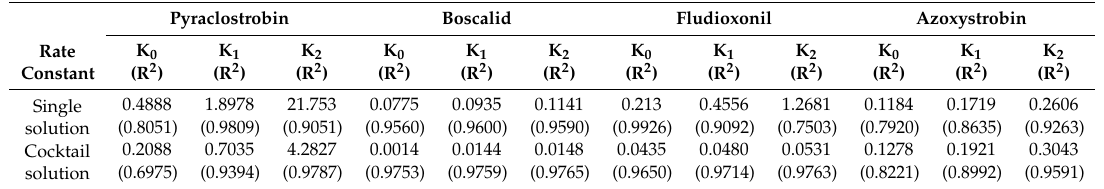
Table 2. Degradation rate constants in single solutions and in a cocktail solution. K 0 (mg L − 1 min − 1 ), K 1 (min − 1 ), K 2 (L mg − 1 min − 1 ), and the corresponding R 2